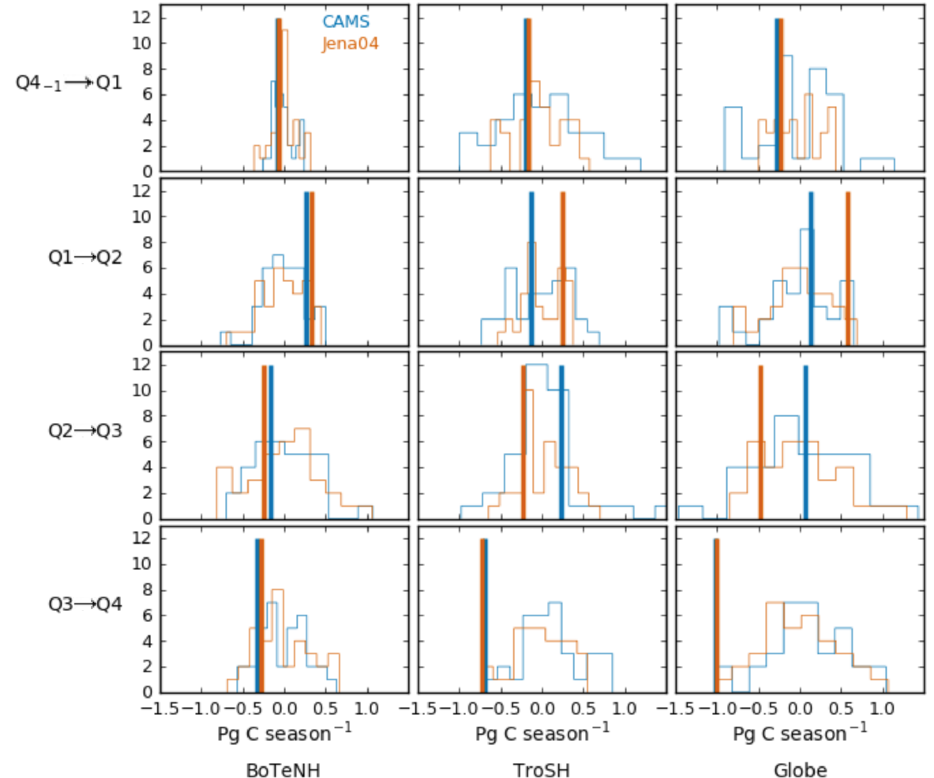
Figure 6. Extremeness of transitions in seasonal land carbon-uptake anomaly in 2015. Lines of histograms for seasonal land carbon-uptake transitions for 1981–2015 are shown for boreal and temperate Northern Hemisphere (BoTeNH, latitude >23.5 ◦ N), tropics and extratropical Southern Hemisphere (TroSH, latitude <23.5 ◦ N) and the whole globe. A transition between two consecutive seasons is defined as the linearly detrended land carbon-uptake anomaly in a given season minus that in the former one. The horizontal-axis shows the seasonal transitions in land carbon-uptake anomalies (Pg C season − 1 ) . Vertical orange solid lines indicate values for 2015.